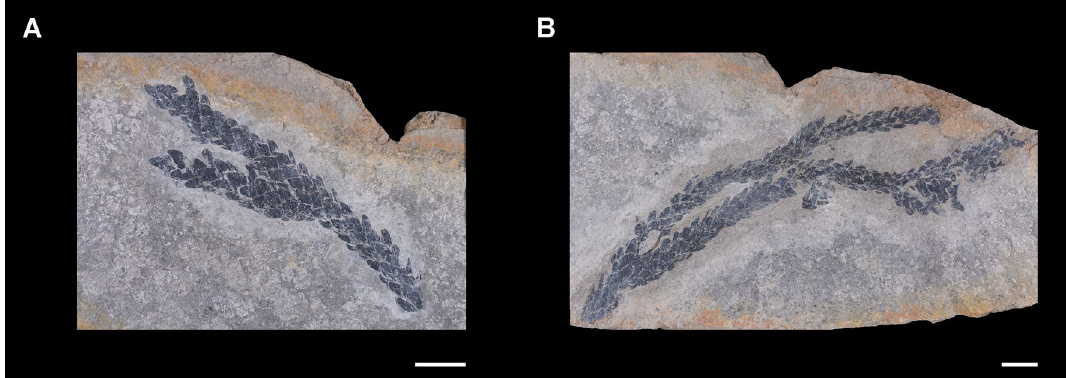
Figure 5. Plant members of the Lower Carnian (Upper Triassic) Polzberg palaeobiota. ( A ) Voltzia sp., GBA 20212007z0170/0001; ( B ) Voltzia sp., GBA 2021/0170/0147. Scale bar: 10 mm. Prepared by AL using CorelDRAW X7; www. corel draw.